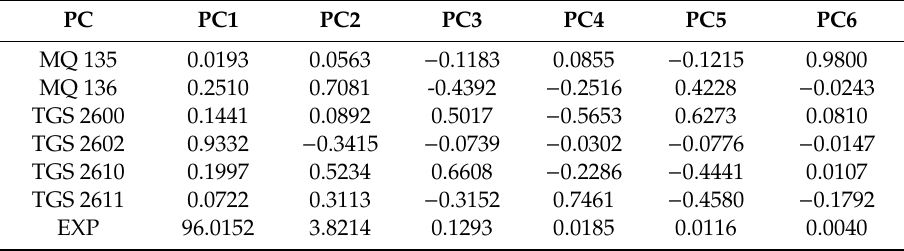
Table 3. Principal component analysis of the sensor array.